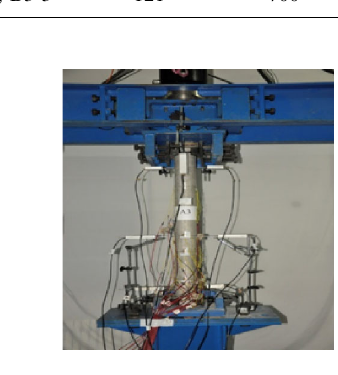
Fig. 7 Photograph of test equipment